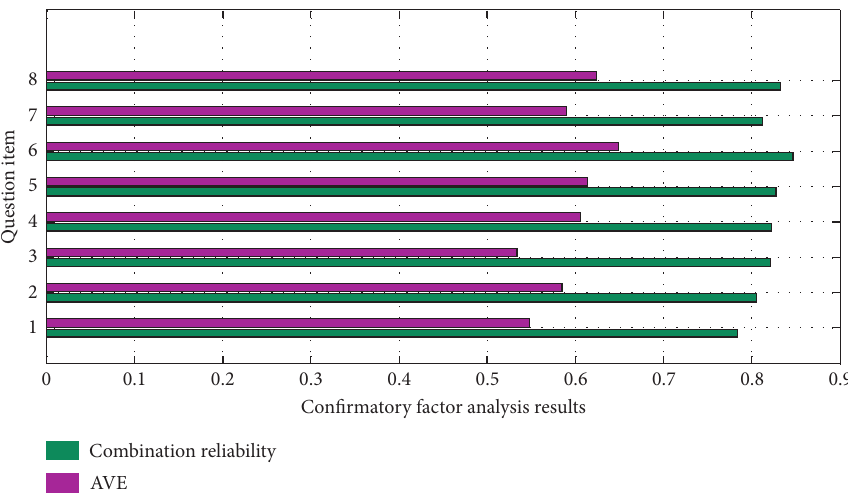
Figure 7: Confirmatory factor analysis results of the growth stage scale.